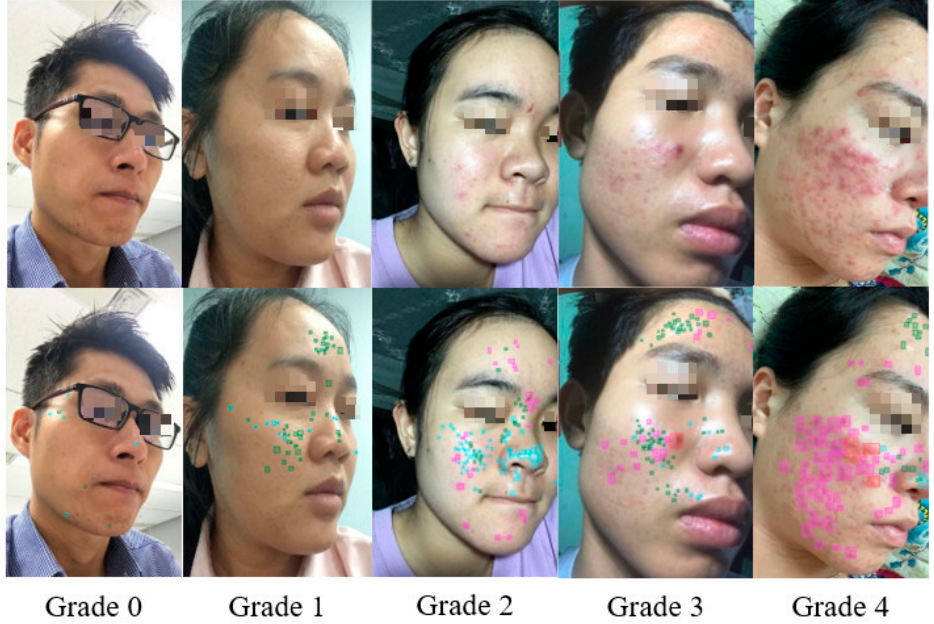
Figure 1. From the original images, dermatologists labeled acne lesions (blackheads/whiteheads, papules/pustules, nodules/cysts, and acne scars) using bounding boxes and graded the acne severity using the IGA scale: grade 0, clear; grade 1, almost clear; grade 2, mild; grade 3, moderate; and grade 4, severe.